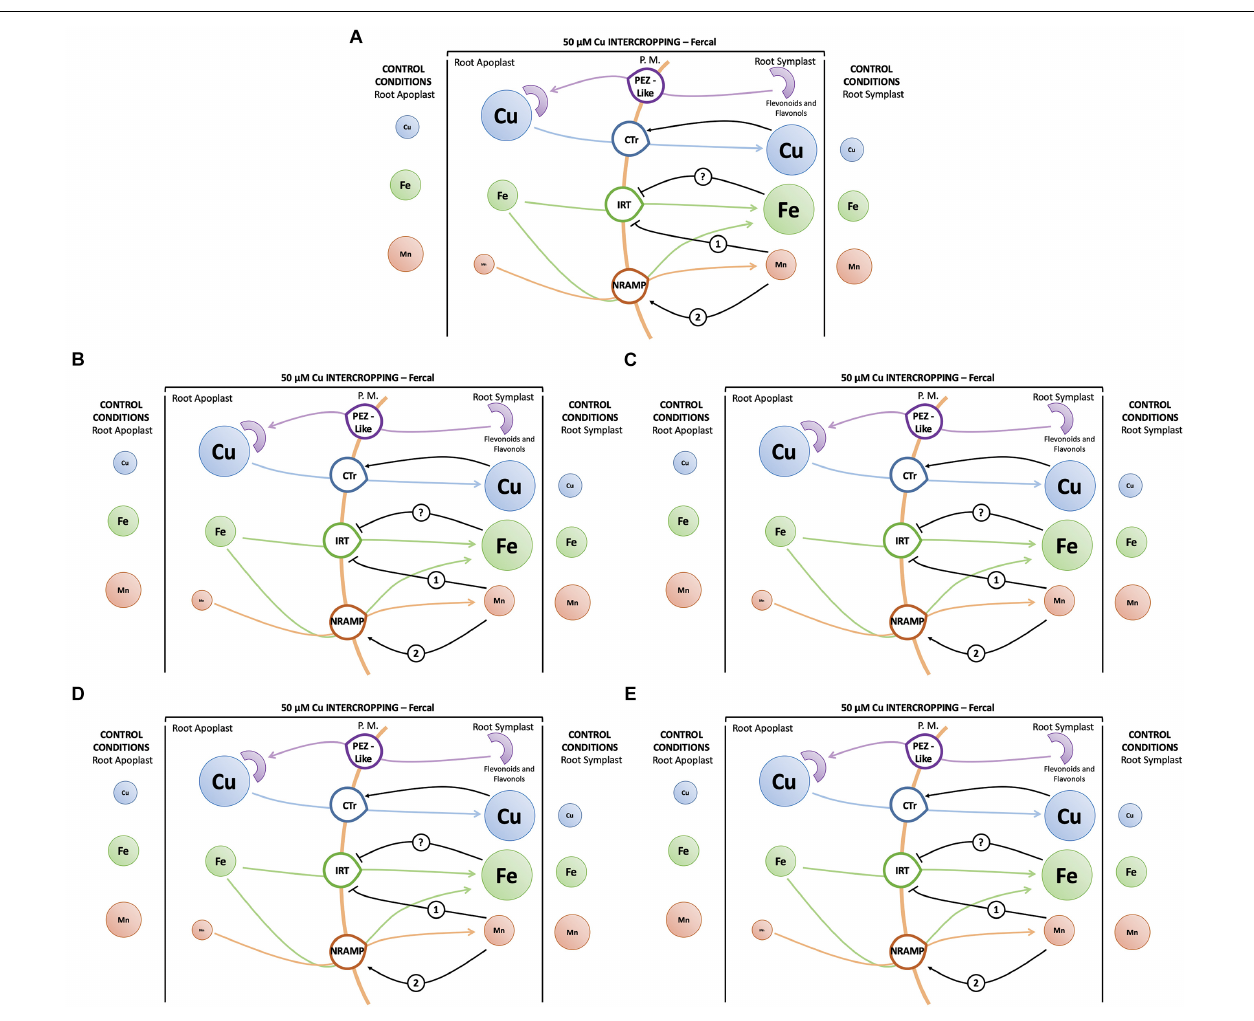
FIGURE 10 | Hypothesis of a root uptake model of cations: (A) Model for monocropped Fercal and 196.17 rootstocks at high Cu concentrations (i.e., 25 and 50 µ M Cu). (B) Model for intercropped Fercal rootstocks in low Cu toxicity (5 µ M Cu). (C) Model for intercropped Fercal rootstocks at high Cu toxicity (50 µ M Cu). (D) Model for intercropped 196.17 rootstocks in low Cu toxicity (5 µ M Cu). (E) Model for intercropped 196.17 rootstock at high Cu toxicity (50 µ M Cu). Size of circles represent the estimated ion concentration in the single compartments. The concentrations data used for the development of the model are taken from this work and from Marastoni et al. (2019). Numbers indicate the sequence of events, the rootstock name on the arrows specify that the description is characteristic for the specified rootstock and not for the